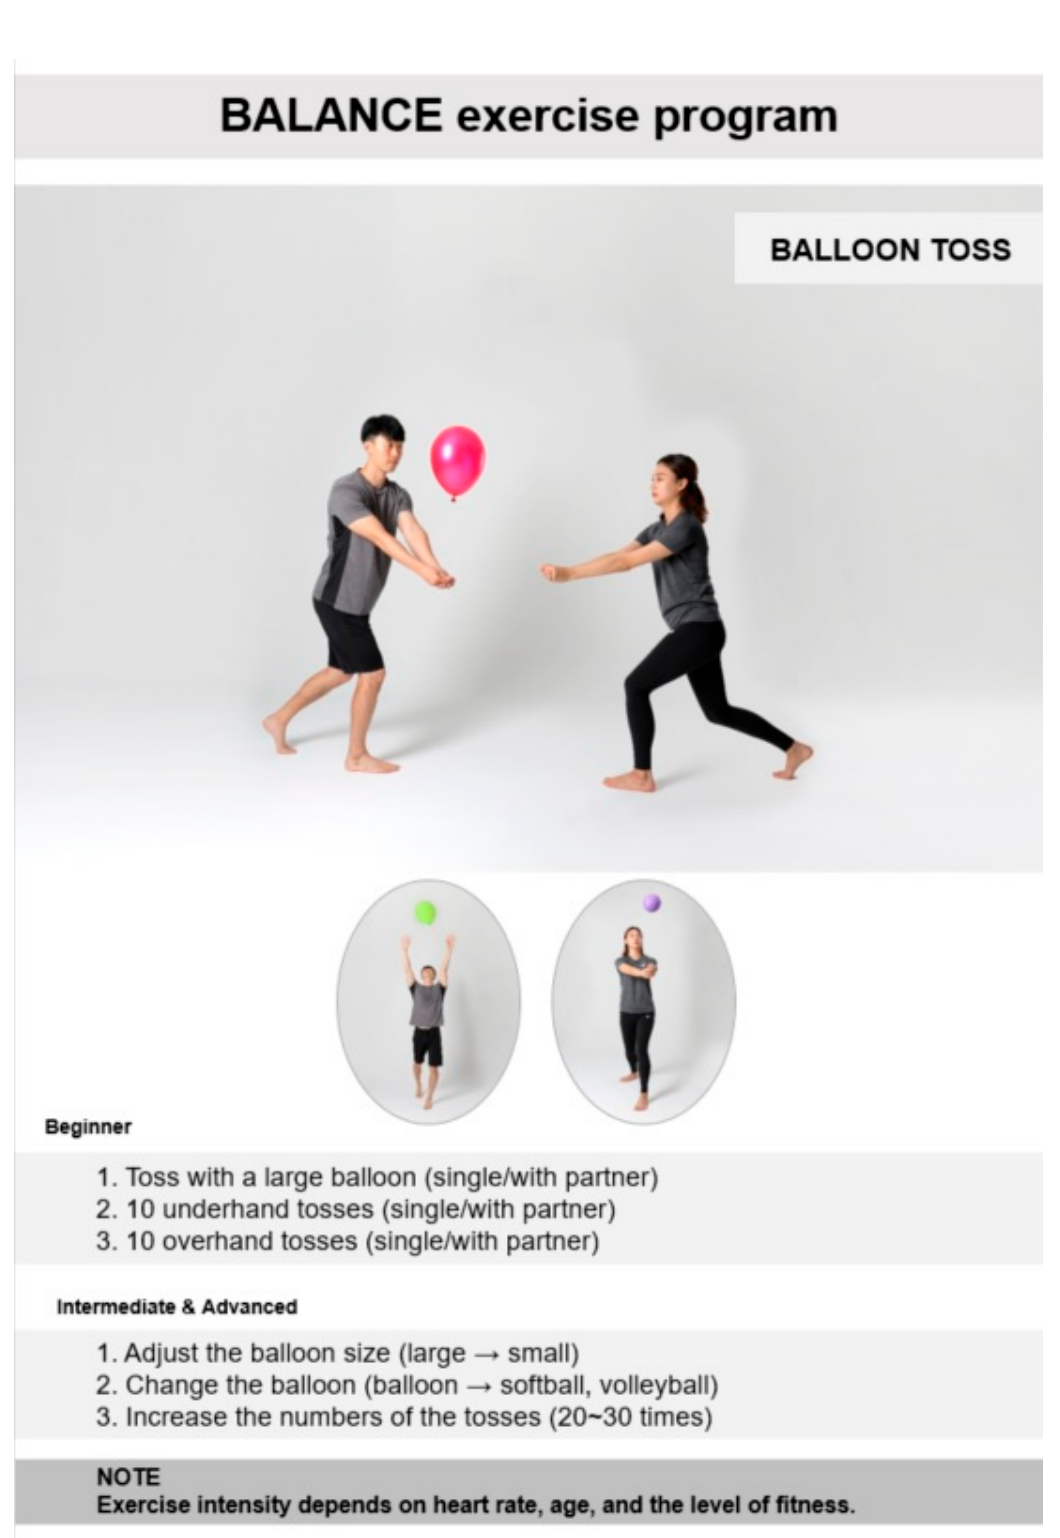
Figure A21. Detailed description and components of each movement in the “Balloon toss” balance exercise.